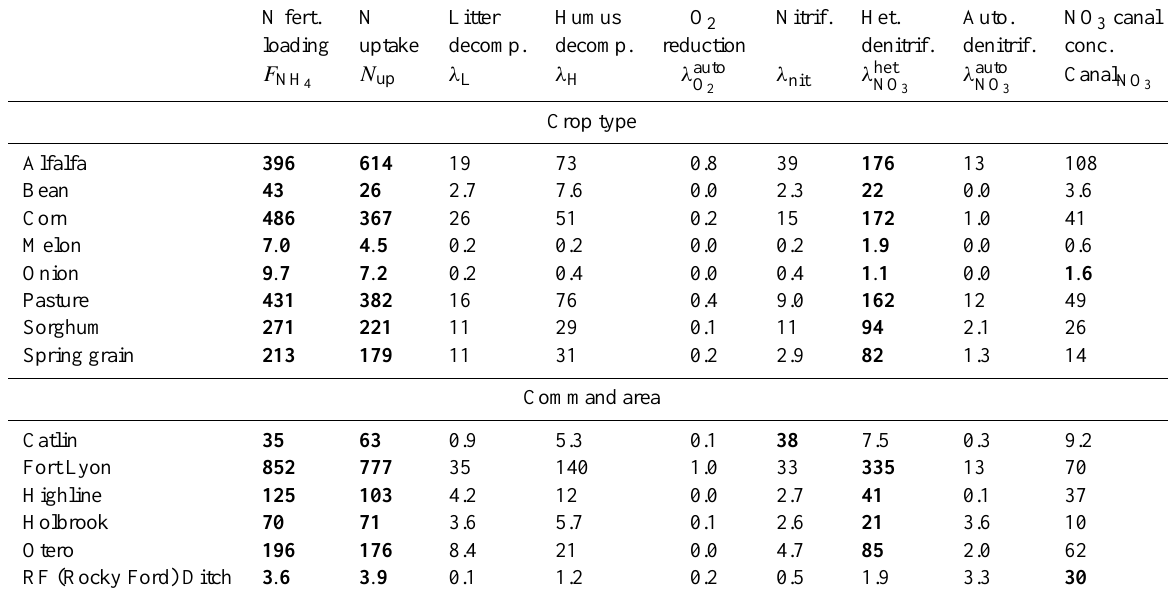
Table 4. Sensitivity index ( µ ∗ ) for each of the model input factors investigated, indicating the degree of parameter influence on NO 3 mass leaching from the shallow soil zone for the grid cells associated with each crop type and command area, with the values of the top three influential parameters for each crop type and command area in